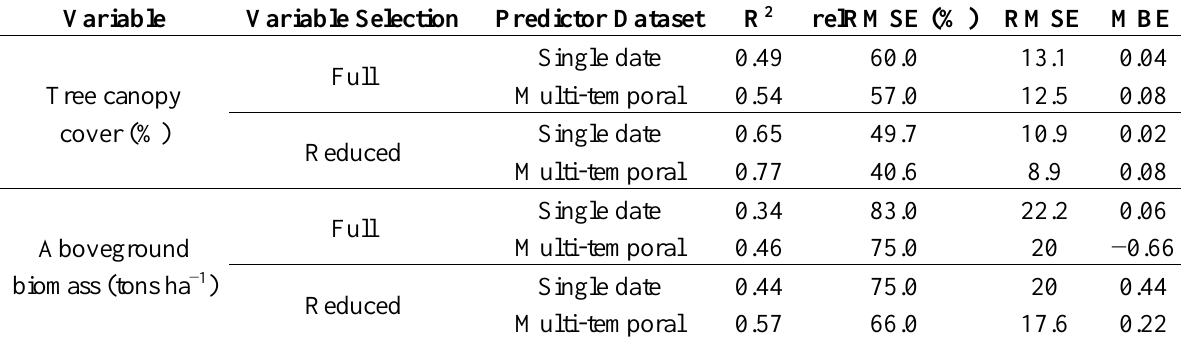
Table 6. Results of model performance evaluation. relRMSE—relative root mean square error; MBE—mean bias error.